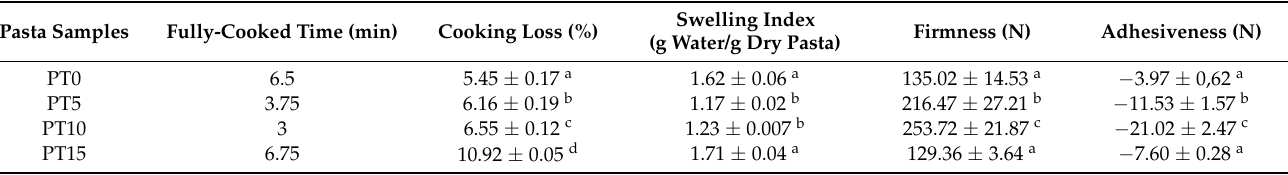
Table 2. Cooking quality parameters and texture analysis of fresh control pasta (PT0) and pasta samples fortified with different DTP substitution levels (5, 10, and 15 g/100 g: PT5, PT10, and PT15, respectively). Values are expressed as mean ± standard